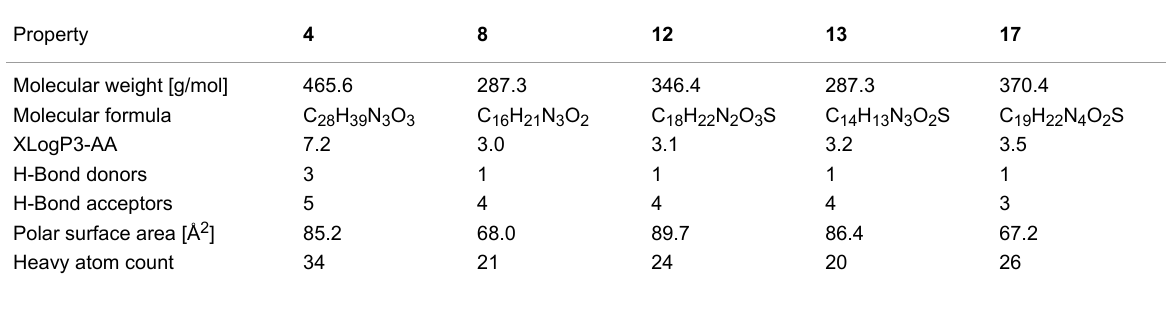
Table 1: Calculated properties of probes.